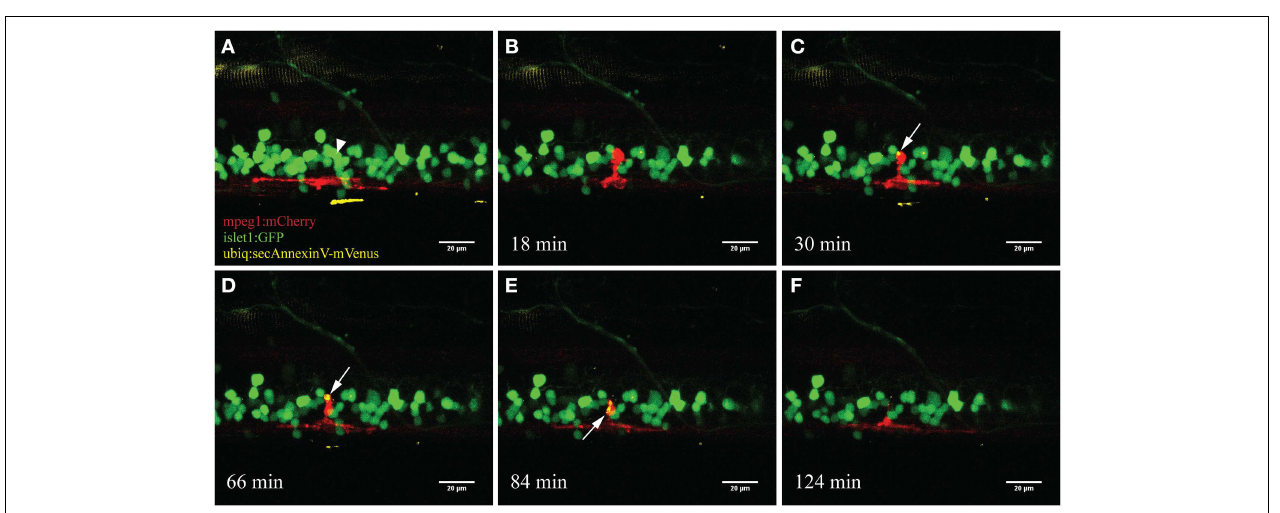
the microglia increases over time (D) , till the phagocytic debris gets transported away from the ablation site (E) and conceivably degraded resulting in disappearance of the fluorescence ( F ). Scale bars = 20 µ m. Supplementary Video 3 shows the time-lapse video of this